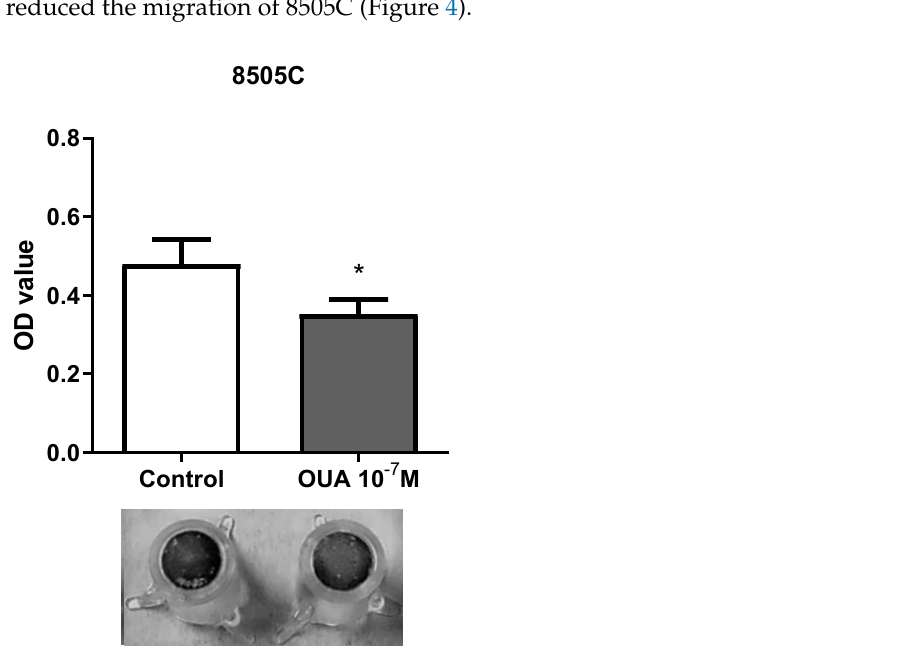
Figure 5. Effect of ouabain on mRNA expression of PAX8 and TTF1 in 8505C cells. Following 24 h of 8505C culture in the absence or presence of ouabain 10 − 7 M, PAX8 and TTF1 mRNA levels were evaluated by RT-PCR. ( a , b ) Data are presented as the mean ± SEM of mRNA levels of PAX8 ( a ) and